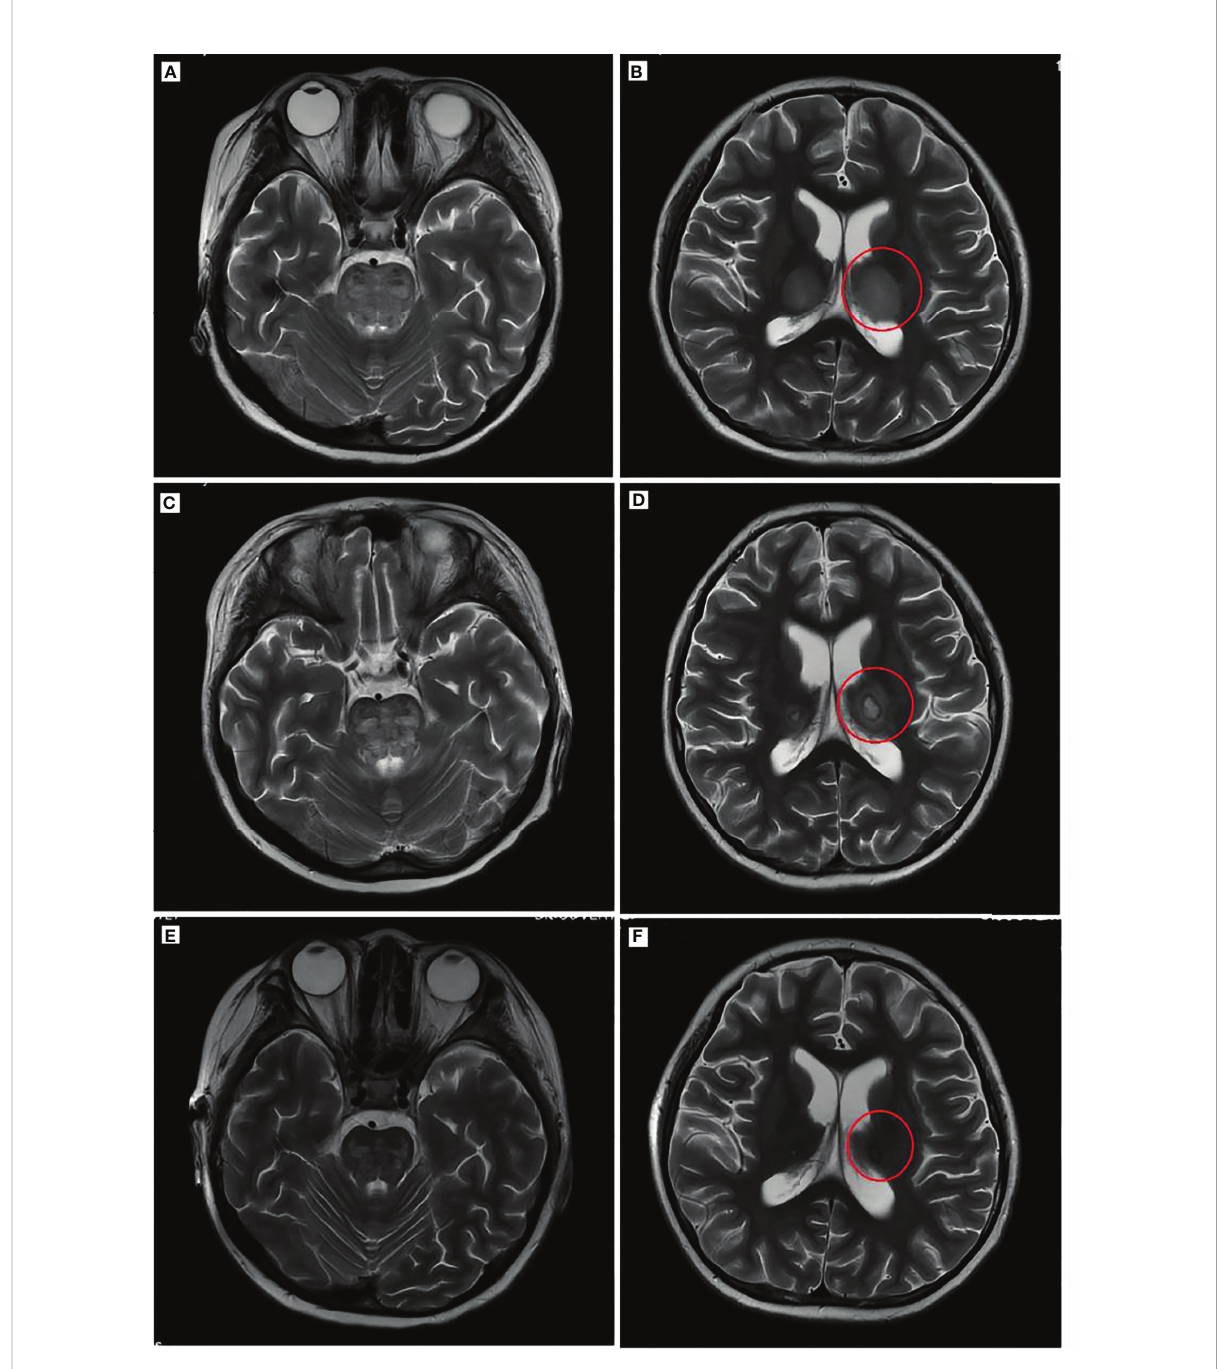
FIGURE 3 Brain imaging of the patient. T2WI (A, B) showed a high brainstem density and thalamus density (red circle). Brain T2WI (C, D) 2 weeks after ANE diagnosis indicated brainstem edema and typical “ concentric circles ” (red circles) within the thalamus. T2WI (E, F) after remission indicated the disappearance of edema and damage in the thalamus and brainstem. T2WI, T2-weighted MRI; PET, positron emission tomography; ANE, acute necrotizing